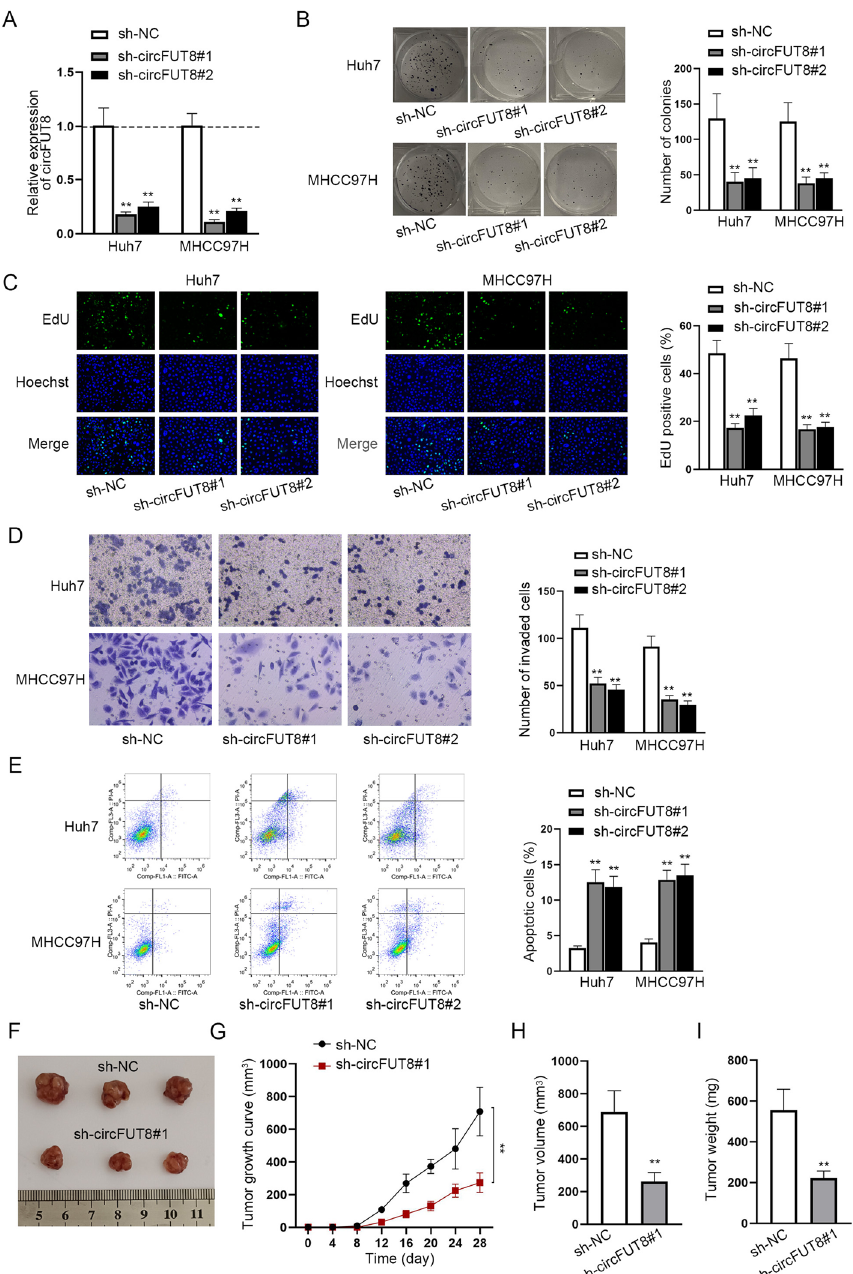
Fig. 2 Inhibition of circFUT8 suppressed HCC cell malignancy and tumor growth. A CircFUT8 expression was reduced by sh-circFUT8#1/2 transfection in HCC cells. B , C Colony formation and EdU assays were conducted to verify the proliferation of HCC cells with the transfection of sh-circFUT8. D The invasion of HCC cells after circFUT8 depletion was evaluated by transwell assays. E The apoptosis rate of HCC cells after circFUT8 depletion was analyzed through flow cytometry. F – I In vivo tumor assays were performed to measure the tumor size, growth, volume, and weight after circFUT8 knockdown. The experimental group treated with sh-circFUT8#1/2 exhibited a significant statistical difference in comparison with the control sh-NC group, with a P -value <